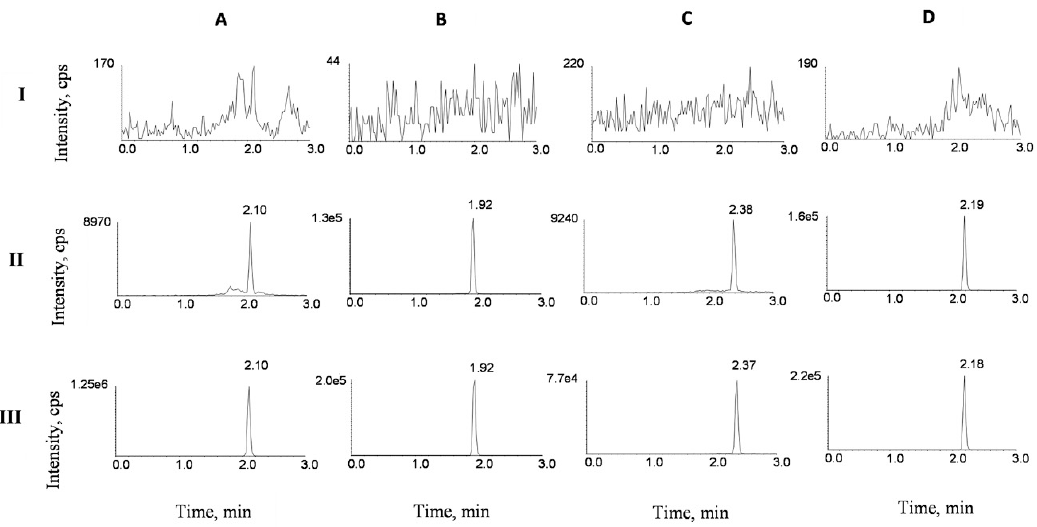
Figure 2. Representative UPLC–MS/MS chromatograms for SVA ( A ), LVA ( B ), SV ( C ) and LV ( D ) in rat plasma samples: (I) a blank plasma sample; (II) a blank plasma sample spiked with SVA, LVA, SV and LV at lower limit of quantitation (LLOQ), and (III) plasma sample of treated rats collected 1 h after the oral administration of a combination of silymarin (45 mg/kg) and SV (80 mg/kg).